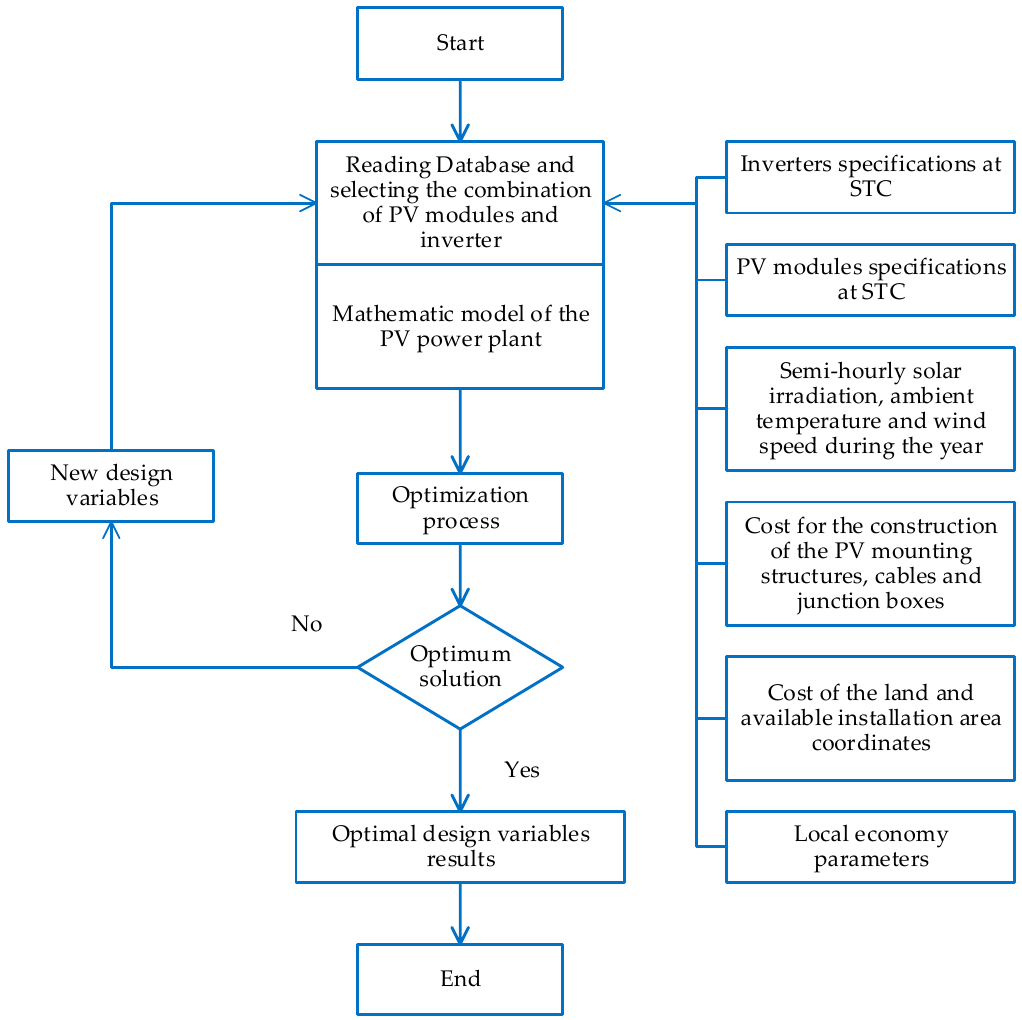
Figure 6. flowchart of the proposed design methodology. Figure 6. Flowchart of the proposed design